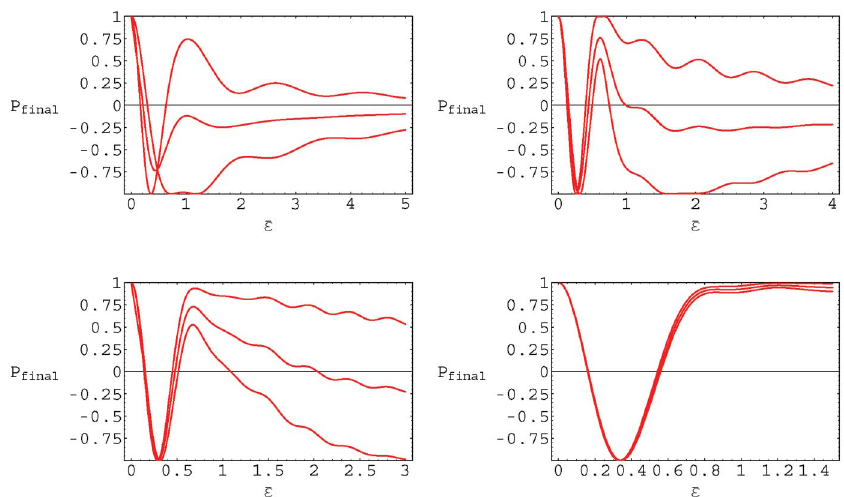
FIG. 11. (Color) Final polarization after triple-crossing a resonance in the pattern of Fig. 10 as function of (cid:5) (cid:3) for four different values of (cid:5) A